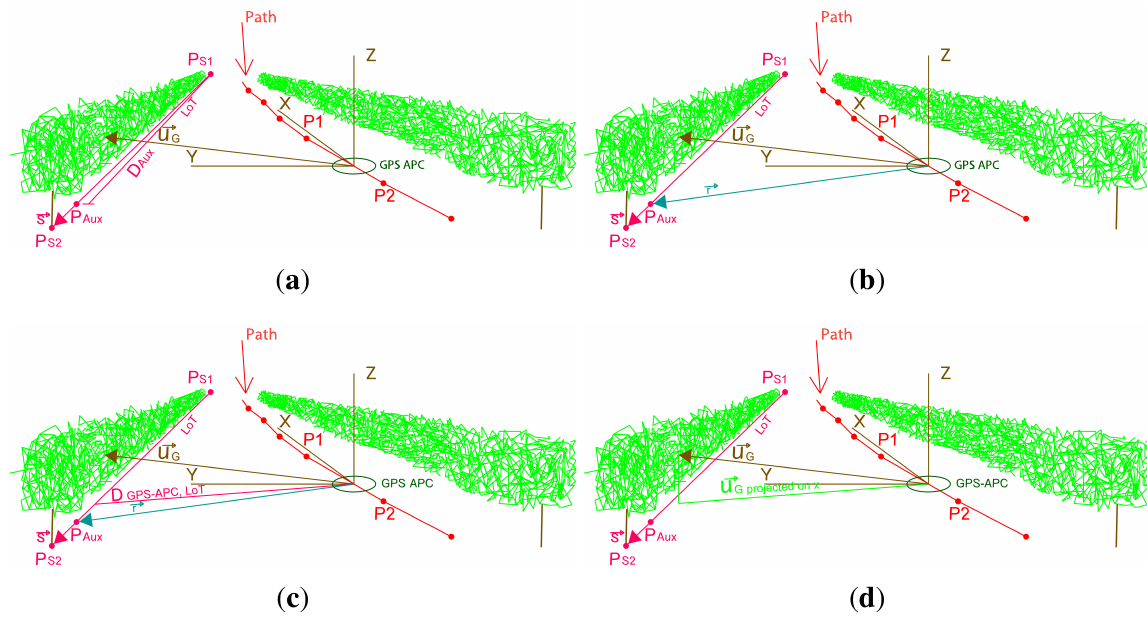
Figure 7. Parameters involved in filtering points that exceed the line of trunks (LoT). ( a ) Distance and auxiliary point; ( b ) the (cid:126)r vector is far from the GPS APC to the auxiliary point P ; ( c ) the distance from the GPS APC to the LoT measured perpendicularly to the Aux (cid:126)s ; ( d ) projected distance from the GPS APC to the vegetation, D